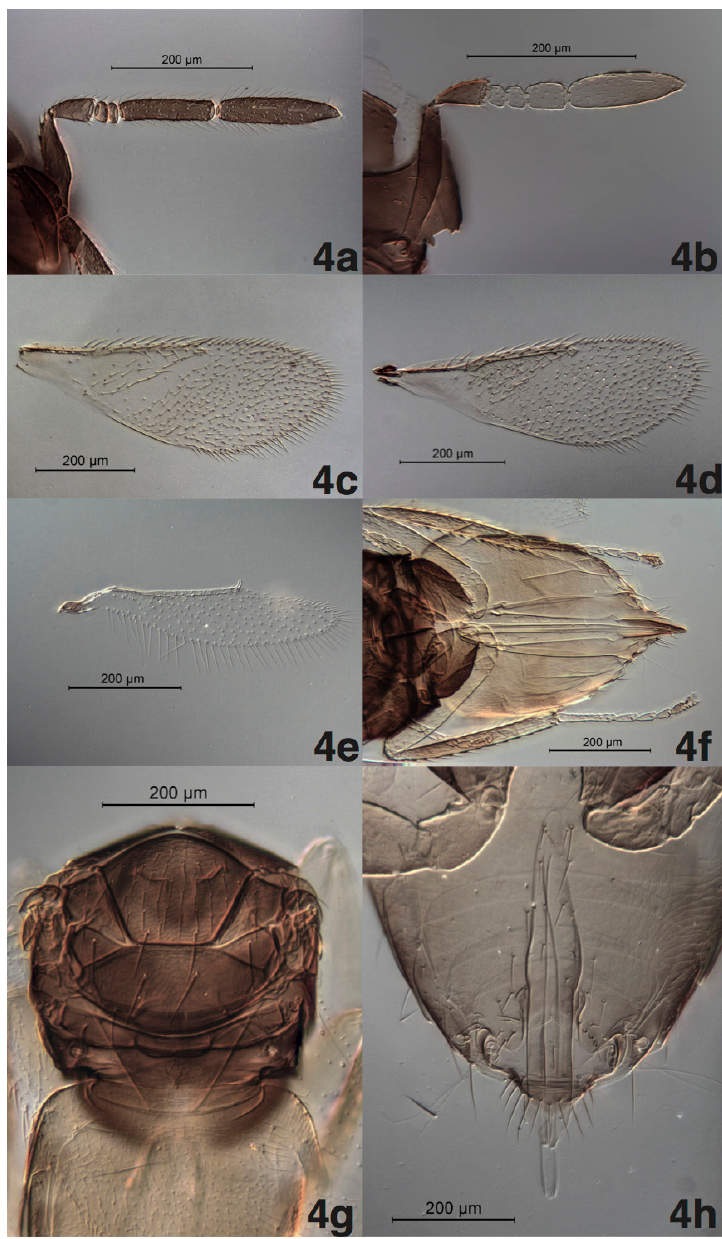
Figure 4. Aphelinus asychis , slide-mounted specimens 4a male, antenna, lateral view (BMNH 1039637) 4b female, antenna, lateral view (TAMU-ENTO X0856569) 4c male, fore wing, dorsal view (TAMU- ENTO X0856303) 4d female, fore wing, dorsal view (TAMU-ENTO X0856301) 4e female, hind wing, dorsal view (TAMU-ENTO X0856301) 4f female, metasoma, ventral view (TAMU-ENTO X0856301) 4g female, mesosoma, dorsal view (TAMU-ENTO X0856301) 4h male, genitalia, ventral view (TAMU- ENTO